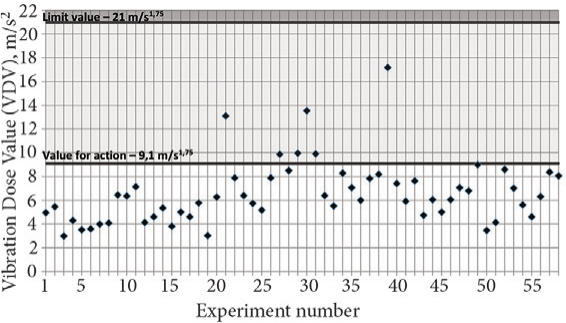
Figure 7. Distribution of the analysed trapezoidal speed humps according to the Vibration Dose